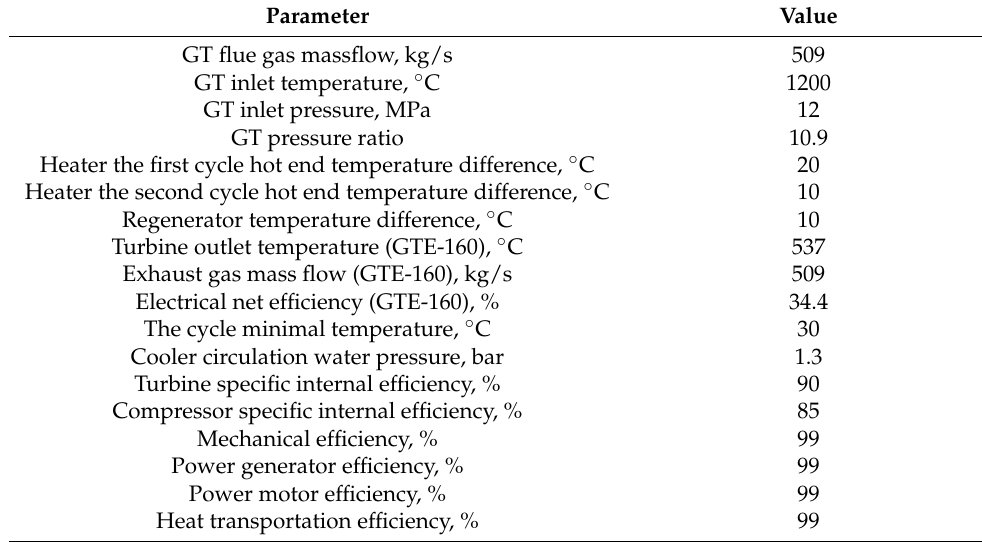
Table 1. Main characteristics and parameters for the calculation of thermal schemes.